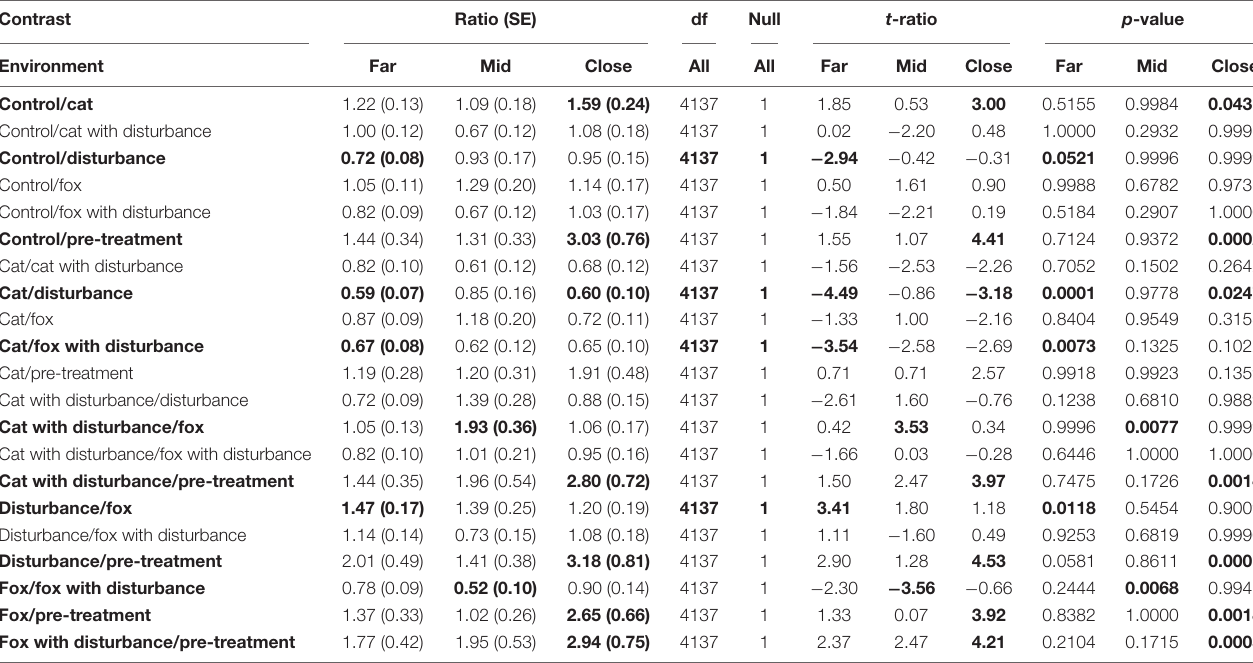
TABLE 4 | Between treatment pairwise contrast ratios for estimated marginal means from generalized linear mixed models with zero inflation and dispersion parameters for the proportion of time spent foraging response, under the explanatory variables of treatment and environment. Contrast Ratio (SE) df t